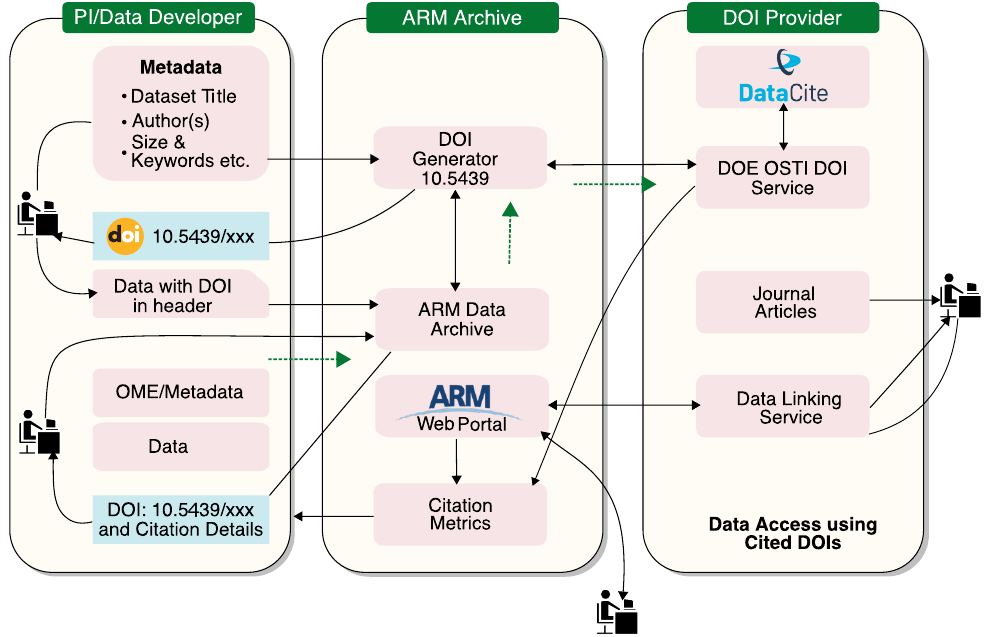
Figure 8. ARM DOI assignment workflow (source: